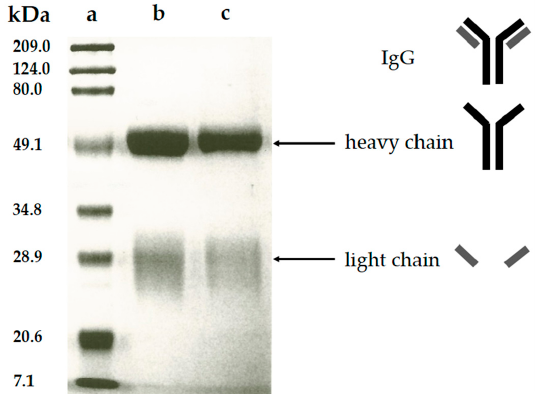
Figure 4. SDS-PAGE pattern of ( a ) protein marker ( b ) commercial IgG from rabbit serum ( c ) purified polyclonal antibody.